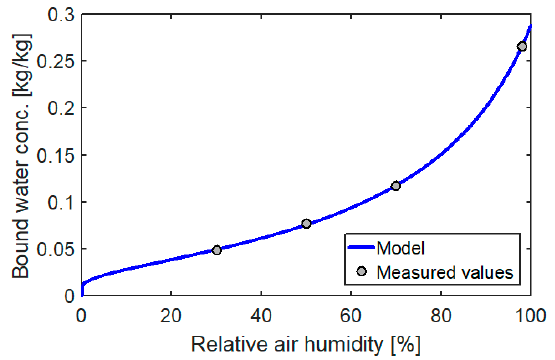
Figure 2. Sorption isotherm of the tested wood.